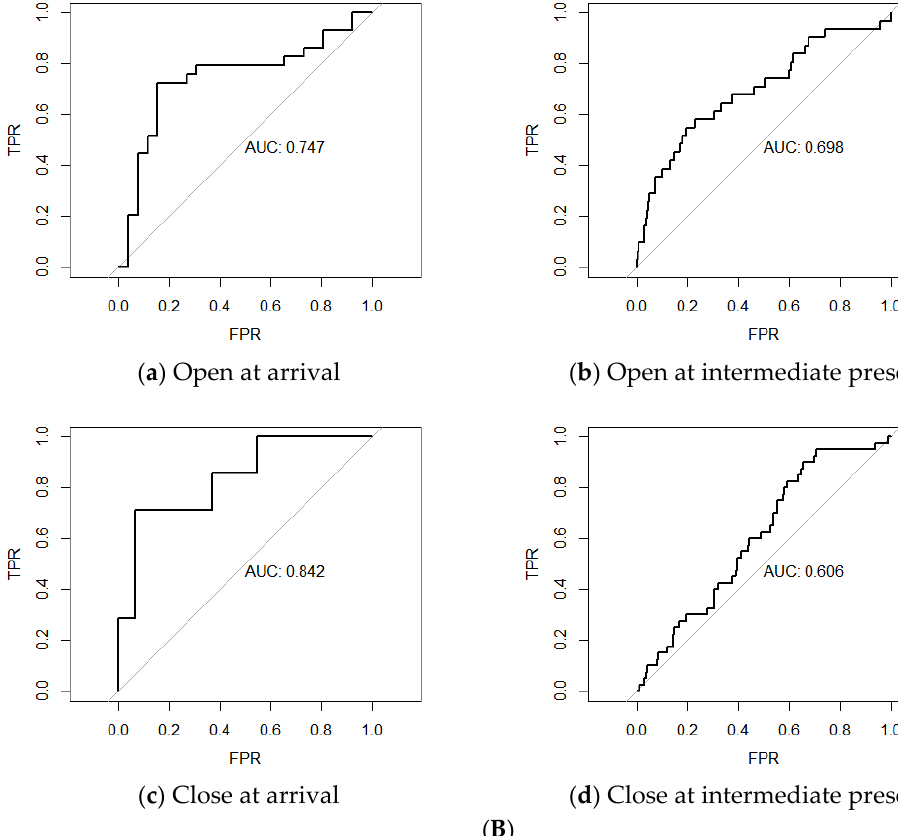
Figure 9. Logistic regression model of window opening behavior. ( A ). Relative humidity and temperature in the offices and outdoors within the measurement period. ( B ). ROC curve and the corresponding AUC of window opening regression model at different time periods. Table 4. Regression model for window use behaviors.